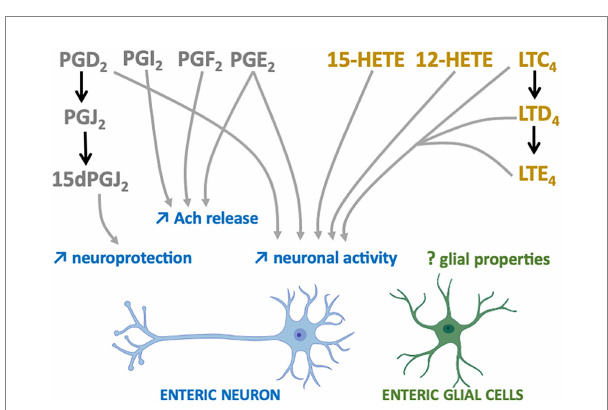
FIGURE 2 n-6 Oxylipins regulate the Enteric nervous system. COX-(grey) or LOX-(yellow) derived n-6 oxylipins increase ( ↑ ) different enteric neuron properties (blue) but their impacts on EGCs remain to be determined